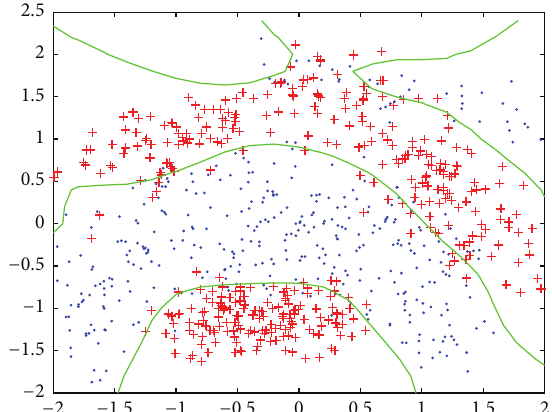
Table 4: Specifications of binary classification cases.